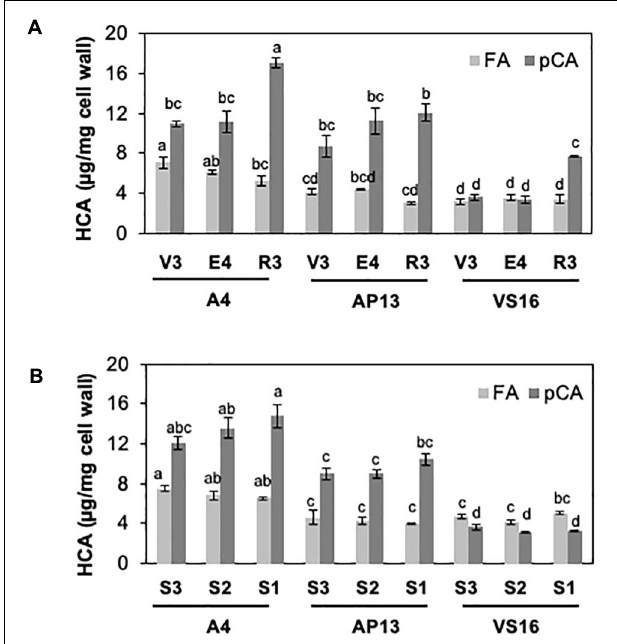
FIGURE 3 | Hydroxycinnamic acids (HCAs), ferulic acid (FA) and para -coumaric acid ( p CA), of switchgrass genotypes A4, AP13, and VS16. Samples, diagramed as in Figure 1 , are arranged from young to old stages/segments. (A) Whole tillers at V3, E4, and R3 developmental stages and (B) S3, S2, and S1 tissue segments of the E4 tiller. Error bars indicate standard error ( n = 3). Means with unshared letters are likely to be significantly different [Tukey’s honestly significant difference (HSD), P ≤